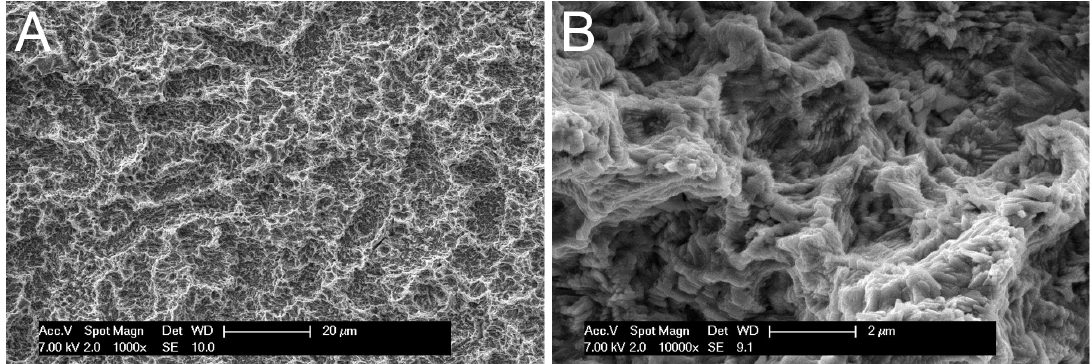
Figure 1. Scanning electron microscopy (SEM) pictures of the surface of an unused screw. ( A ) At low magnification (1000×), the surface is carved by irregular, multi-scale hollows reminiscent of a fractal structure; the specimen appears perfectly clean and devoid of any contamination. ( B ) At higher magnification (10,000×), picture shows the random topography and the fine texturing of the surface, limited only by the grain structure of the metal.